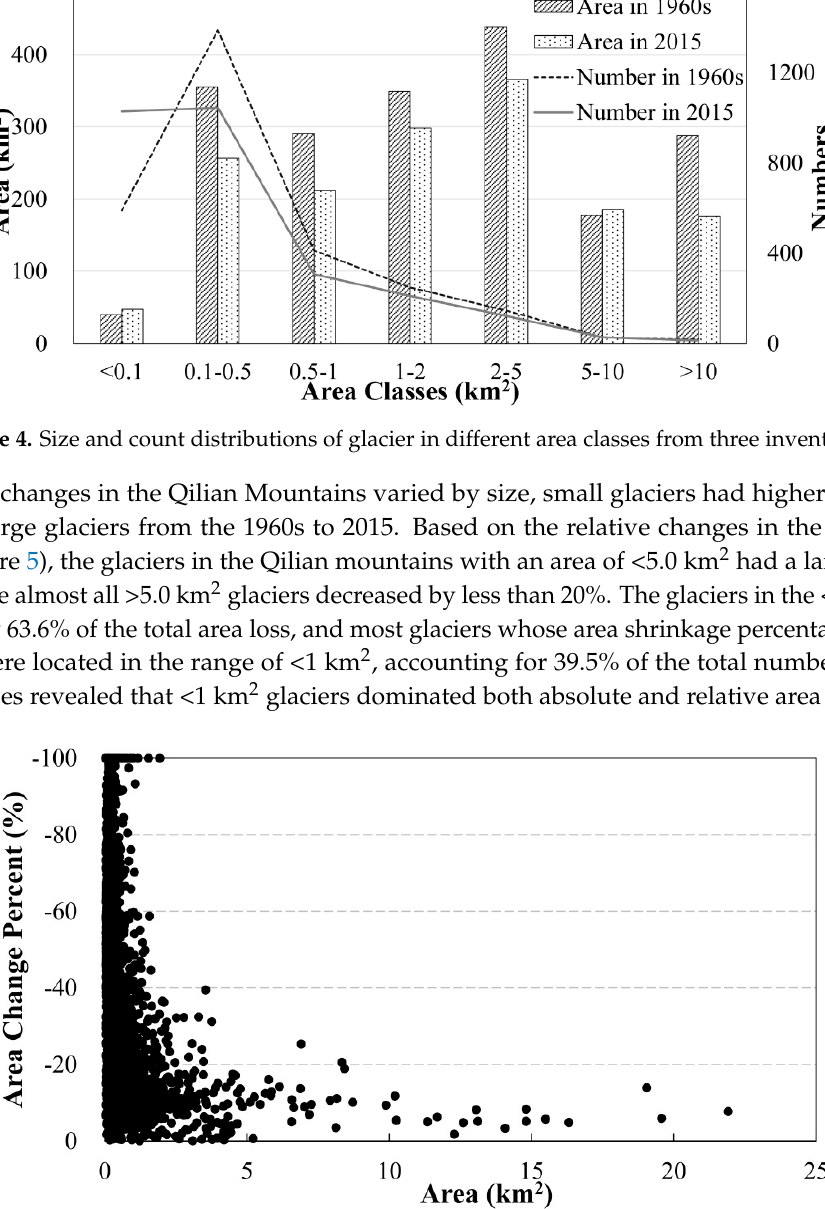
Figure 5. The area change percentage in glaciers in the Qilian Mountains from the 1960s to